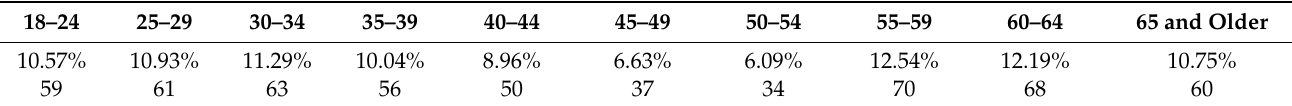
Table 2. Respondents’ age distribution [17].